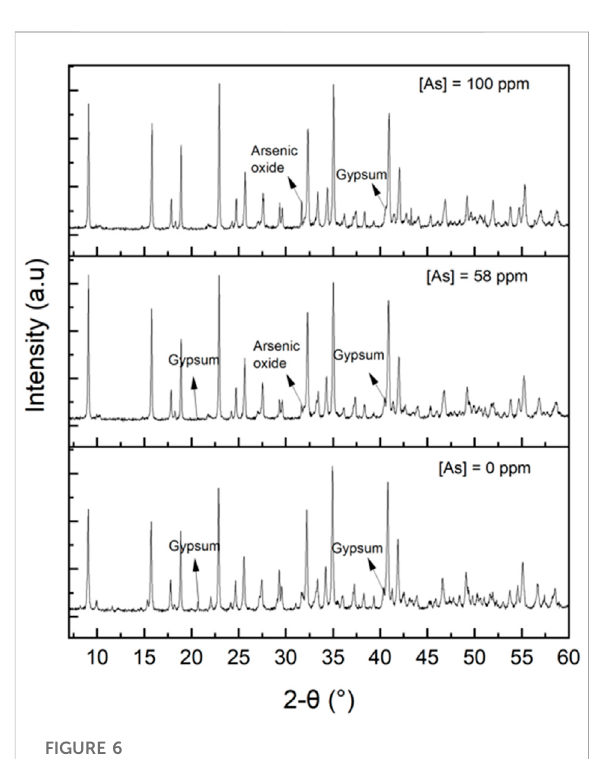
FIGURE 6 X-ray diffraction (XRD) patterns of the precipitates synthesized in the absence of arsenic, in the presence of 58 ppm arsenic, and 100 ppm